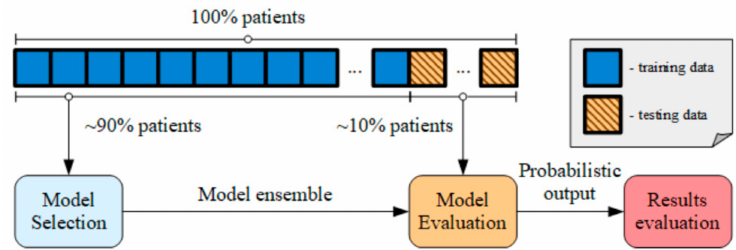
Figure 5. Model evaluation routine using 10-fold cross-validation.